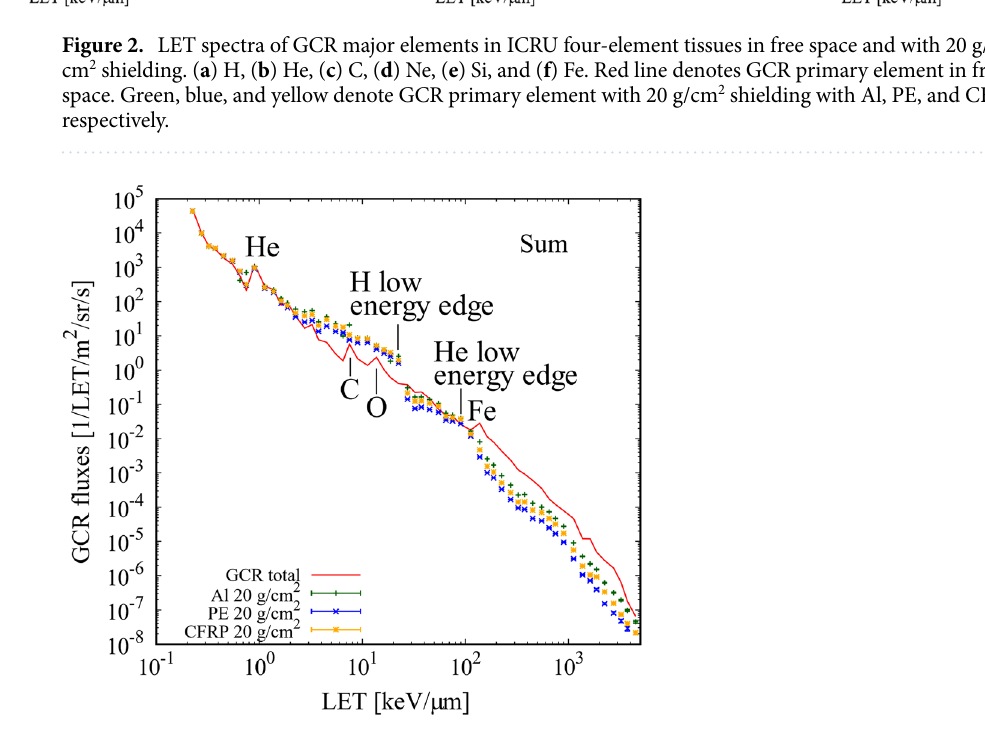
Figure 3. Summed LET spectra of Fig. 2a–f. Total GCR primary particles in free space (red line) and with 20 g/ cm 2 shielding with Al (green), PE (blue), and CFRP